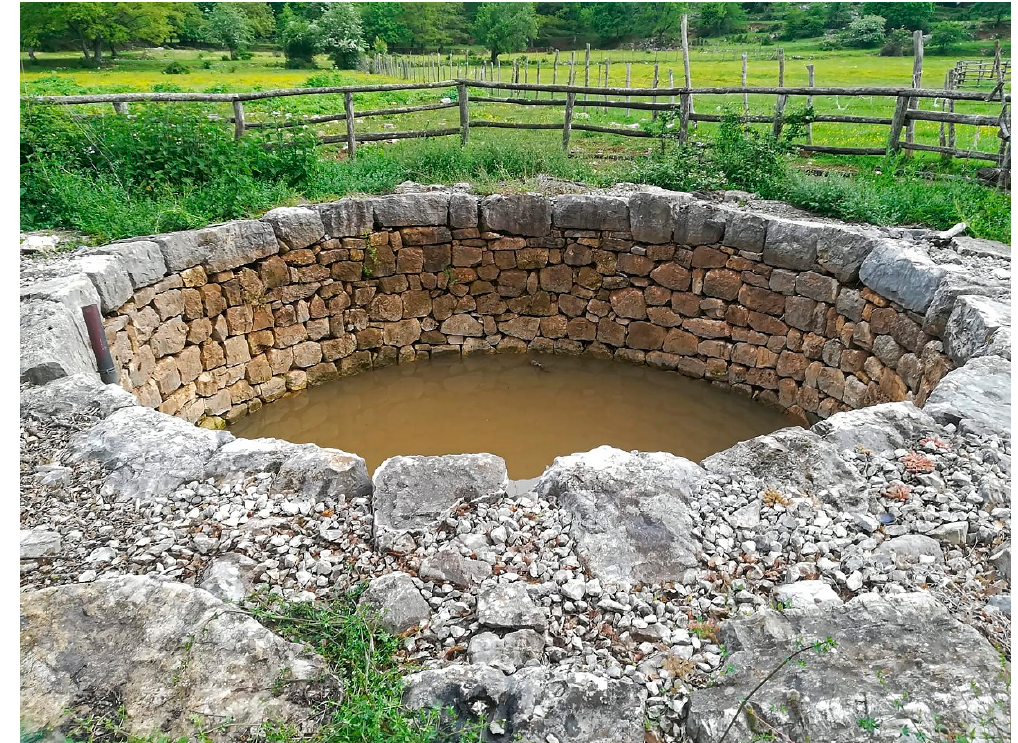
Figure 2. A typical well used as water reservoir in the study area. All the sampled wells, characterized by this same structure consisting of vertical stony walls with the upper margin just one small step above the ground, are easily colonized by newts.